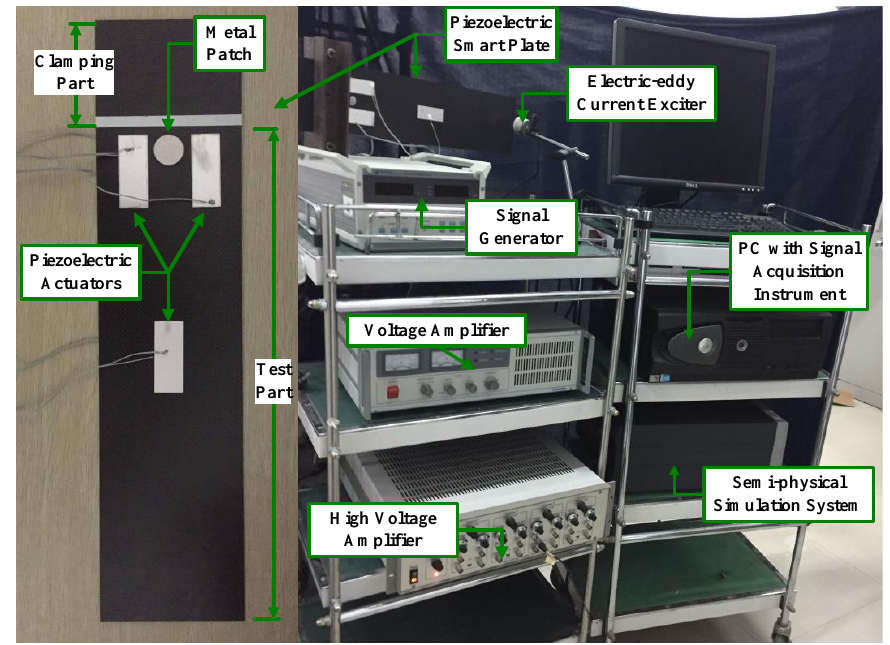
Figure 16. Experimental devices and the specimen.